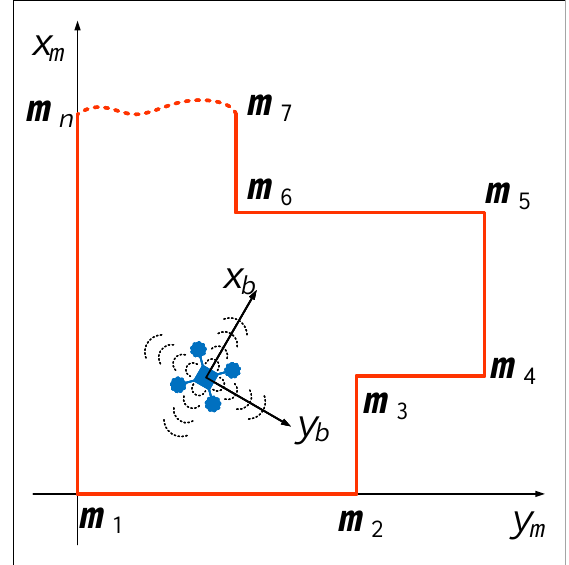
Figure 8. The map and body coordinate